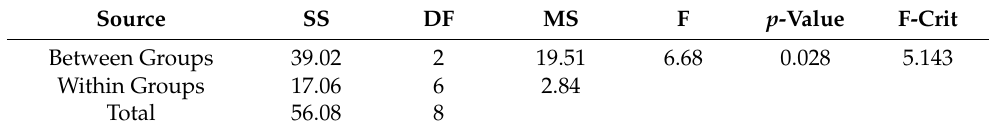
Table 7. Variance analysis of influence of weeding operation speed on inter-row weeding rate.